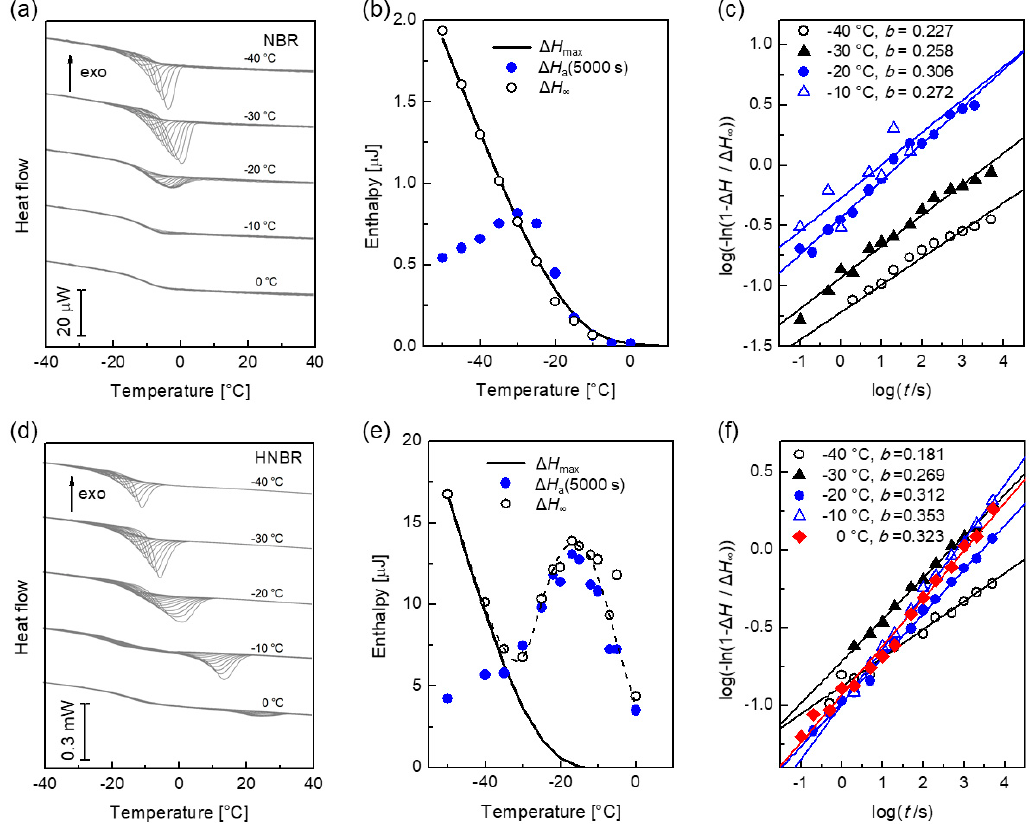
Figure 7. Measured annealing behavior of NBR (above) and HNBR (below) at selected annealing temperatures: ( a ) measurement curves of NBR. ( b ) Enthalpy as a function of temperature: solid circles are the enthalpy after annealing for 5000 s, the open circles are the maximum enthalpy for the curve fit with Equation (12). The curve is the maximum enthalpy determined from the FDSC cooling curve with Equation (11). ( c ) Representation of the enthalpy change during annealing in the linearized diagram (Equation (13)). ( d ) Measurement curves of HNBR. ( e ) Enthalpy versus temperature. ( f ) Linear representation of the enthalpy change during annealing.